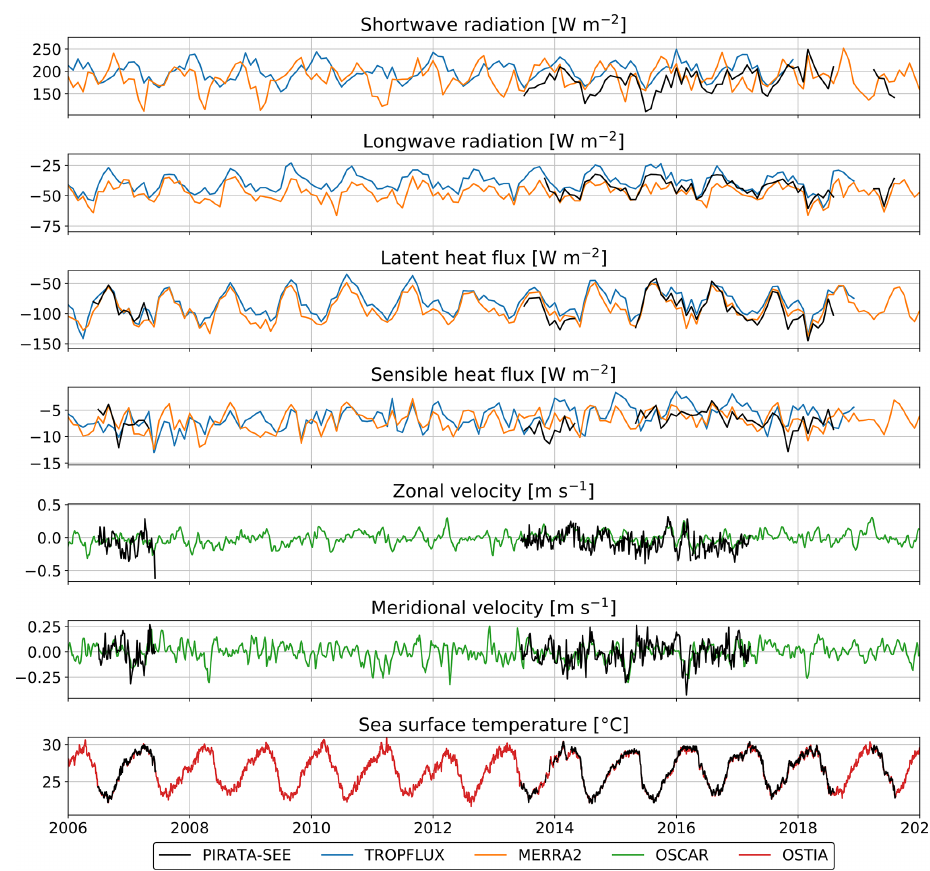
Figure A1. Time series of variables (see titles of panels) of the ML heat budget at 6 ◦ S, 8 ◦ E from in situ data collected at the PIRATA-SEE mooring (black line) and from satellite and reanalysis data (colours, see legend). The daily PIRATA-SEE data are interpolated on the same time grid as the satellite and reanalysis